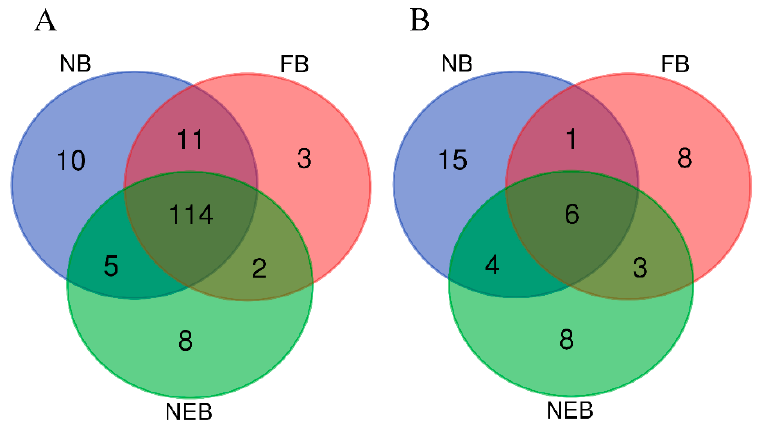
Figure 2. Distribution of known miRNAs ( A ) and novel miRNAs ( B ) in the nurse bee (NB), forager bee (FB), and newly-emerged bee (NEB) libraries. Table 2. Ten highest expressed miRNAs in the hypopharyngeal glands of nurse bee, forager bee, and newly-emerged bee. Nurse Rank